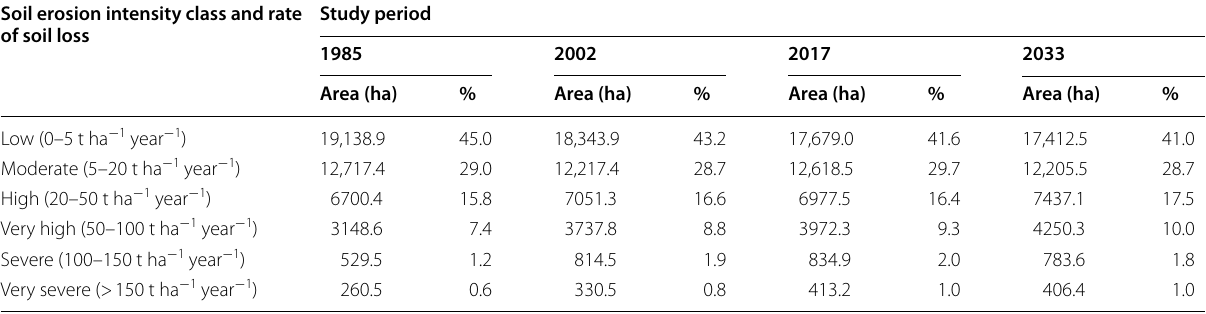
Table 9 Annual soil erosion risk classes and area coverage under land use/land cover map of 198,2002, 2017, and 2033 in Muga watershed Soil erosion intensity class and rate of soil loss